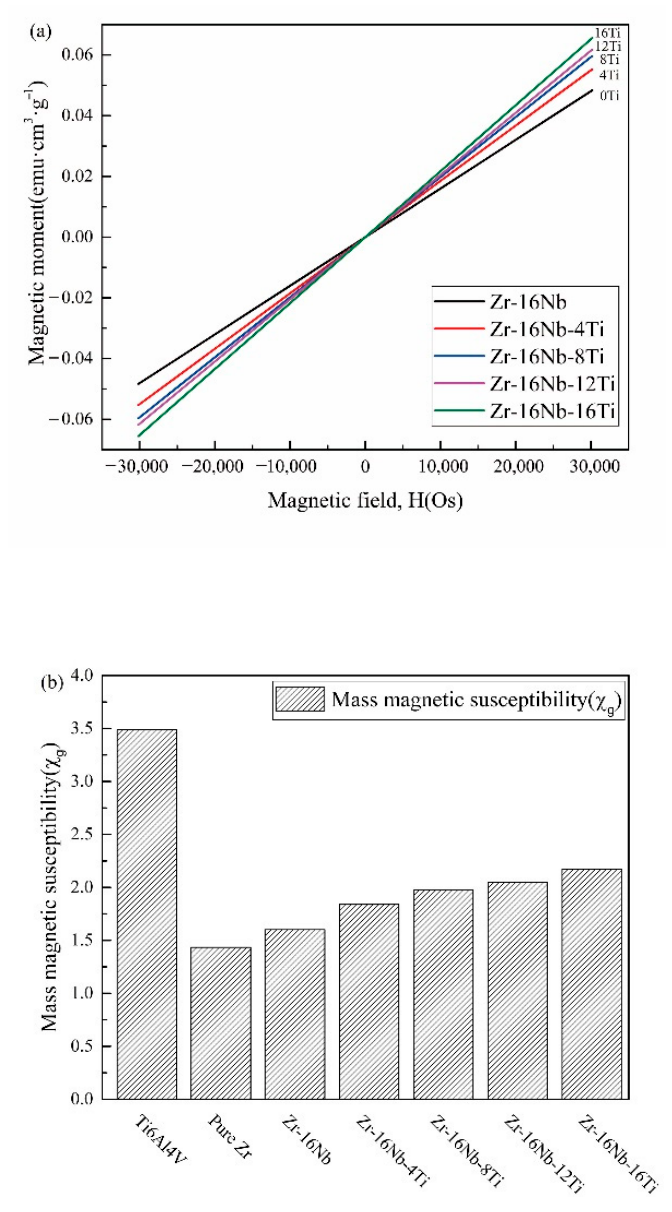
Figure 6. ( a ) Magnetizing curves of Zr-16Nb-xTi and ( b ) magnetic susceptibility of the Zr-16Nb-xTi alloys and contrast samples.